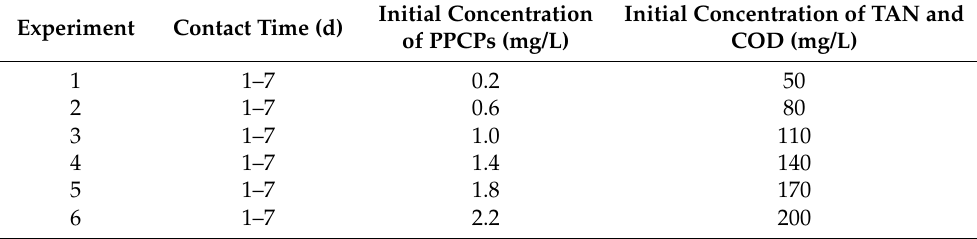
Table 1. Operation conditions used in the different